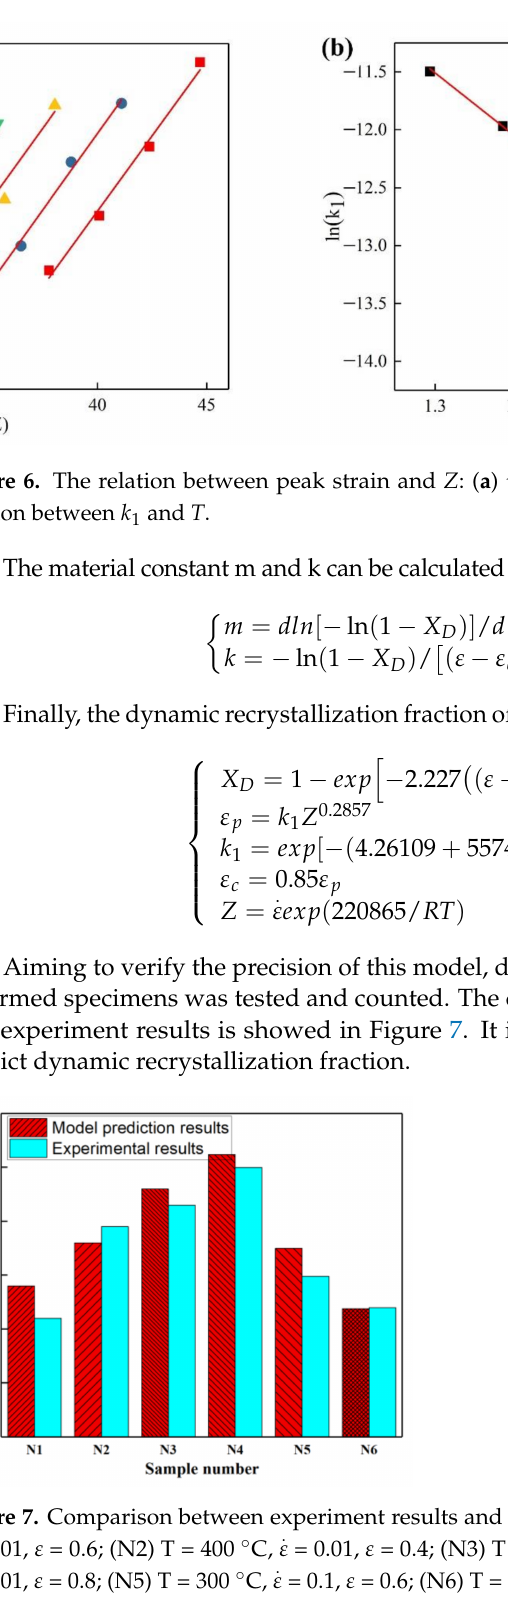
. ε = 0.01, ε = 0.4; (N3) T = 400 ◦ C, . ε = 0.1, ε = 0.6; (N6) T = 300 ◦ C,